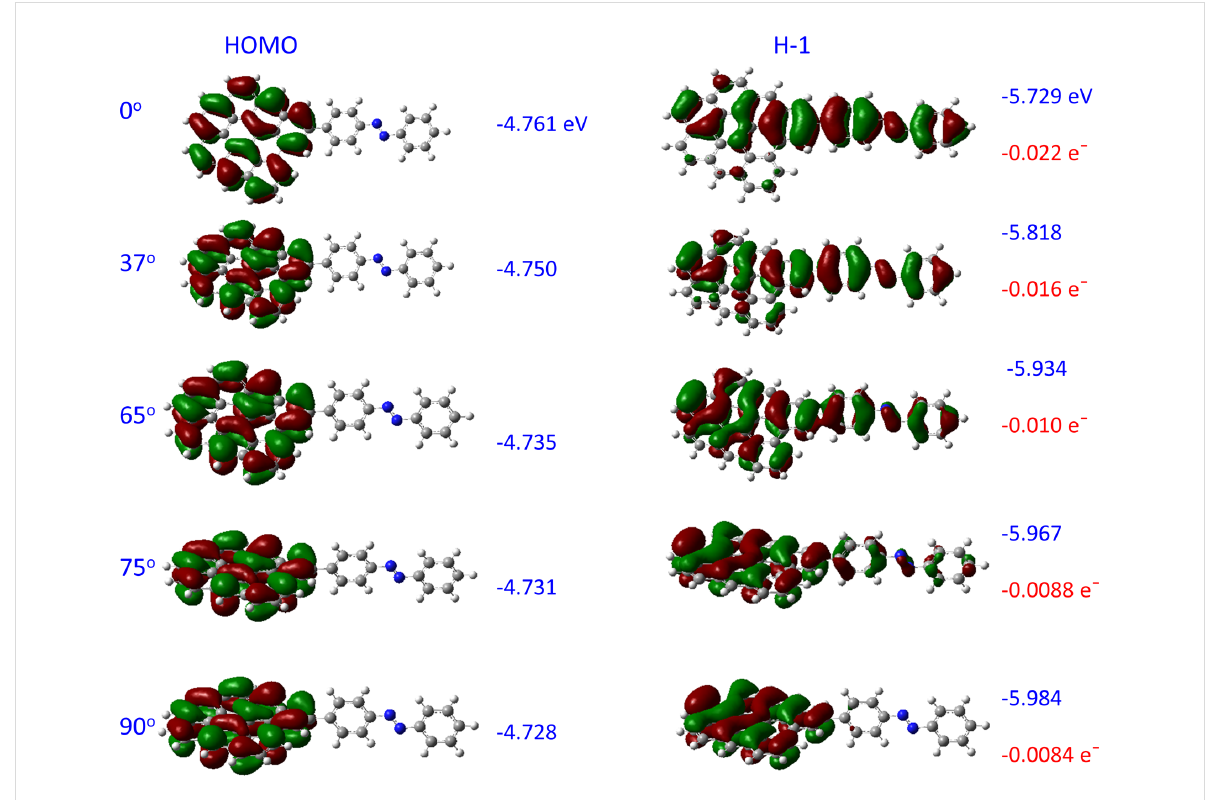
Figure 3: HOMO and H − 1 orbitals for G9–AB for a range of dihedral angles between the G9 plane and AB aromatic rings, indicated at left. Orbital energies for all orbitals are indicated in blue, while the sum of the Mulliken charges on the AB moiety is indicated in red. A negative Mulliken charge indicates partial electron transfer from G9 to AB upon forming the covalent G9–AB cluster.